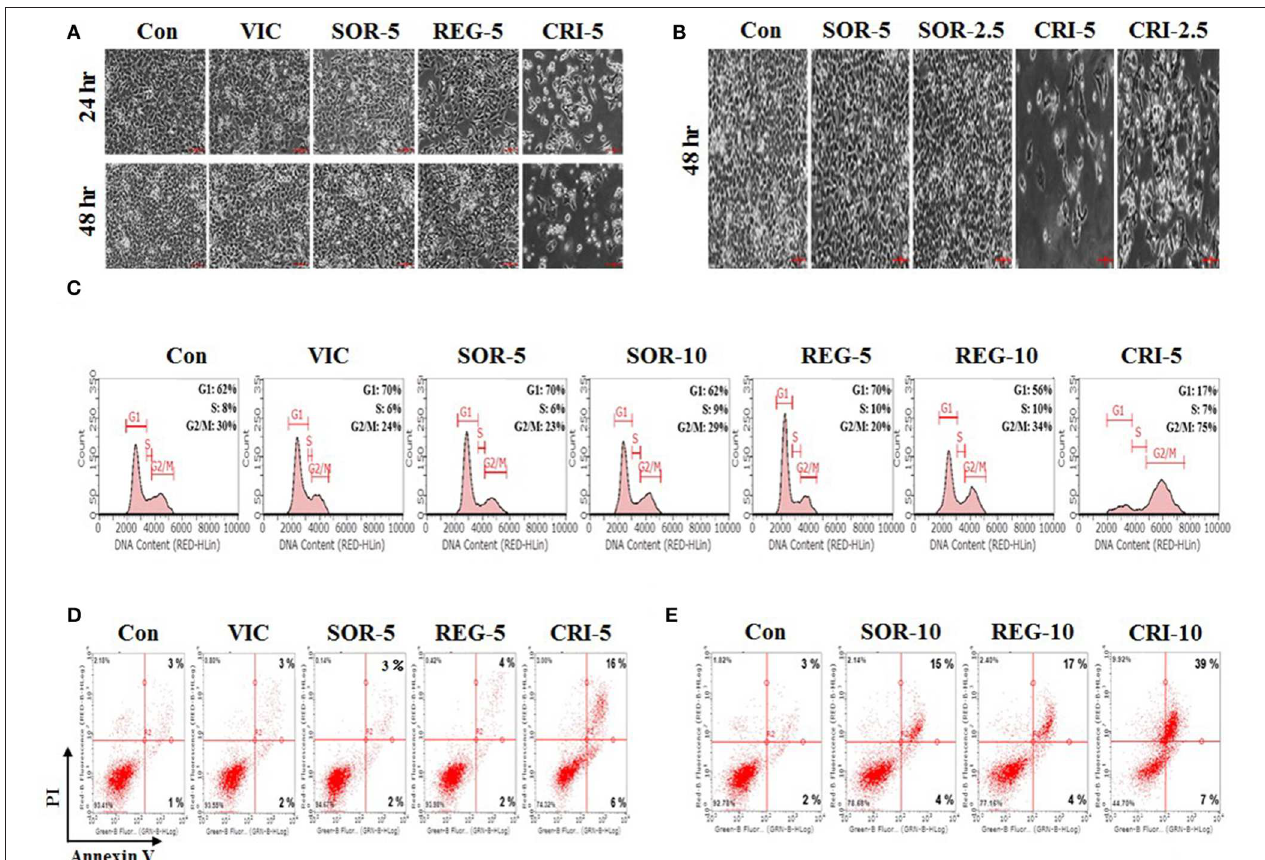
FIGURE 2 | Low-dose crizotinib sensitizes drug-resistant KBV20C cells via apoptosis due to G2 arrest. (A,B) KBV20C cells were grown on 60 mm-diameter dishes and treated with VIC, 5nM vincristine; SOR-2.5, 2.5 µ M sorafenib; SOR-5, 5 µ M sorafenib; REG-5, 5 µ M regorafenib; CRI-2.5, 2.5 µ M crizotinib; CRI-5, 5 µ M crizotinib; or 0.1% DMSO (Con). After 24 or 48h, all cells were observed using an inverted microscope at × 10 magnification. (C) KBV20C cells were grown on 60 mm-diameter dishes and treated with VIC, 5nM vincristine; SOR-5, 5 µ M sorafenib; SOR-10, 10 µ M sorafenib; REG-5, 5 µ M regorafenib; REG-10, 10 µ M regorafenib; CRI-5, 5 µ M crizotinib; or 0.1% DMSO (Con). After 24h, flowcytometry analyses were performed as described in Materials and Methods. (D,E) KBV20C cells were grown on 60 mm-diameter dishes and stimulated with VIC, 5nM vincristine; SOR-5, 5 µ M sorafenib; SOR-10, 10 µ M sorafenib; REG-5, 5 µ M regorafenib; REG-10, 10 µ M regorafenib; CRI-5, 5 µ M crizotinib; CRI-10, 10 µ M crizotinib; or 0.1% DMSO (Con). After 24h, Annexin V analyses were performed as described in Materials and